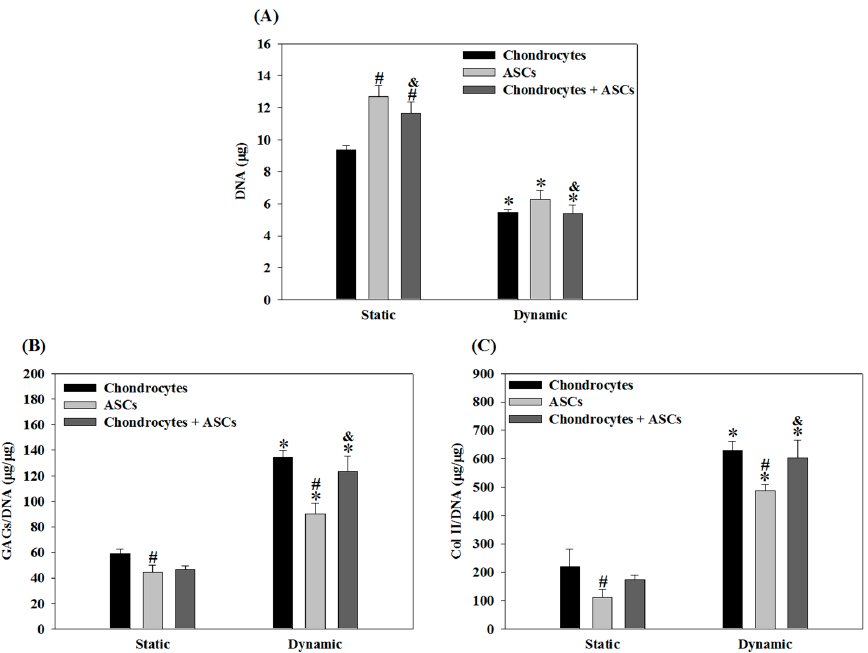
Figure 5. Proliferation and extracellular matrix (GAGs and Col II) production when chondrocytes, ASCs or chondrocytes + ASCs were cultured in cryogel scaffolds for 14 days under static or cyclic compressive loading (frequency = 1 Hz, strain = 20% and duration = 3 h/day) conditions. Cell number: 10 5 chondrocytes/scaffold for the chondrocytes group; 10 5 ASCs/scaffold for the ASCs group; 5 × 10 4 chondrocytes/scaffold and 5 × 10 4 ASCs/scaffold for the chondrocytes + ASCs group. ( A ) DNA; ( B ) GAGs/DNA; ( C ) Col II/DNA. * p < 0.05 compared with static; # p < 0.05 compared chondrocytes; & p < 0.05 compared with ASCs.